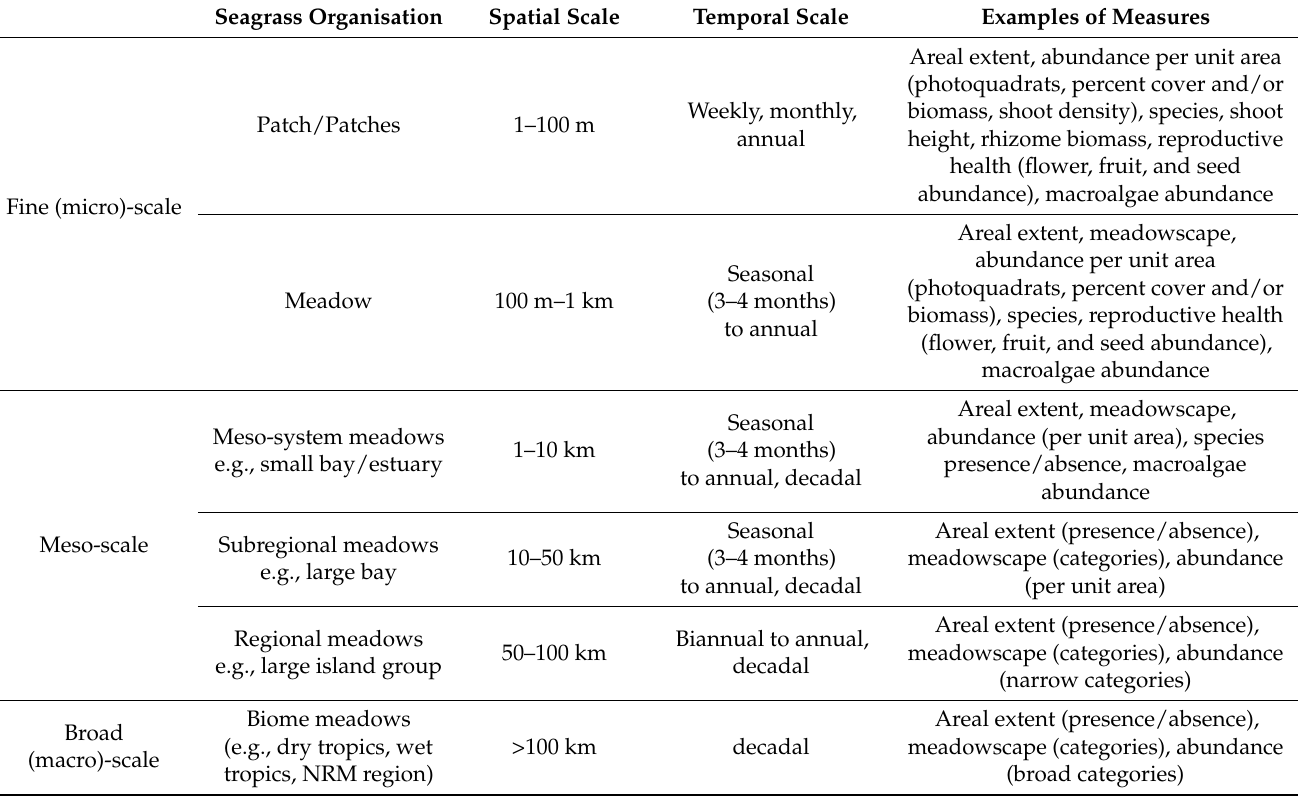
Table 2. Seagrass organisation form, spatial scale, temporal scales, and features measured. Spatial scale = maximum and minimum area covered by seagrass organisation form; Temporal scale = time scale on which the seagrass organisation form undergoes changes; Measures = features of the seagrass organisation form able to be measured. Modified [38].